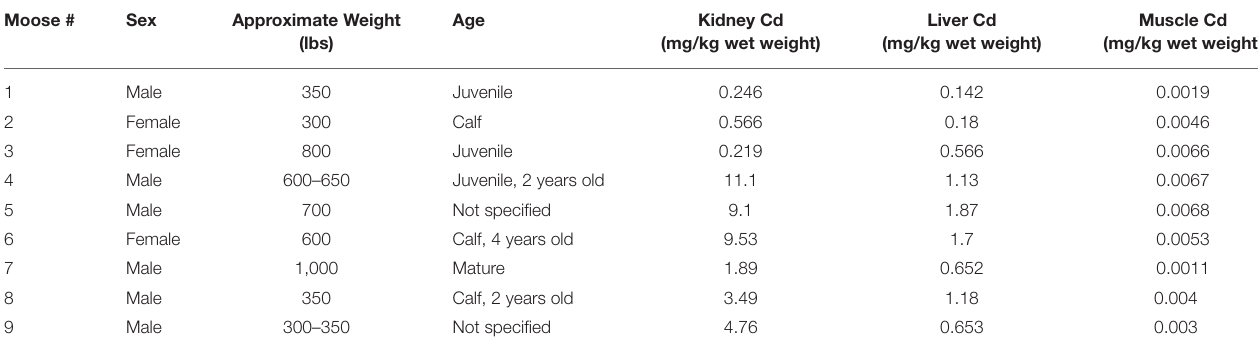
TABLE 4 | CLFN Moose Details (sex, age, weight, and tissue concentrations).